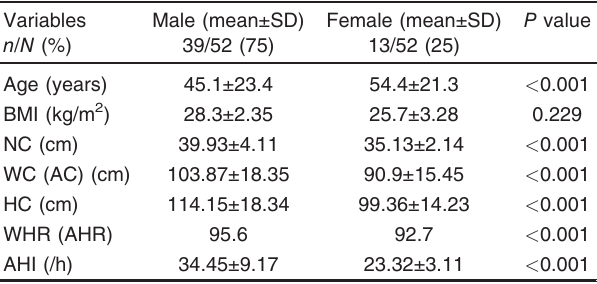
Table 3 Comparison between sex and anthropometric values among obstructive sleep apnea patients Variables